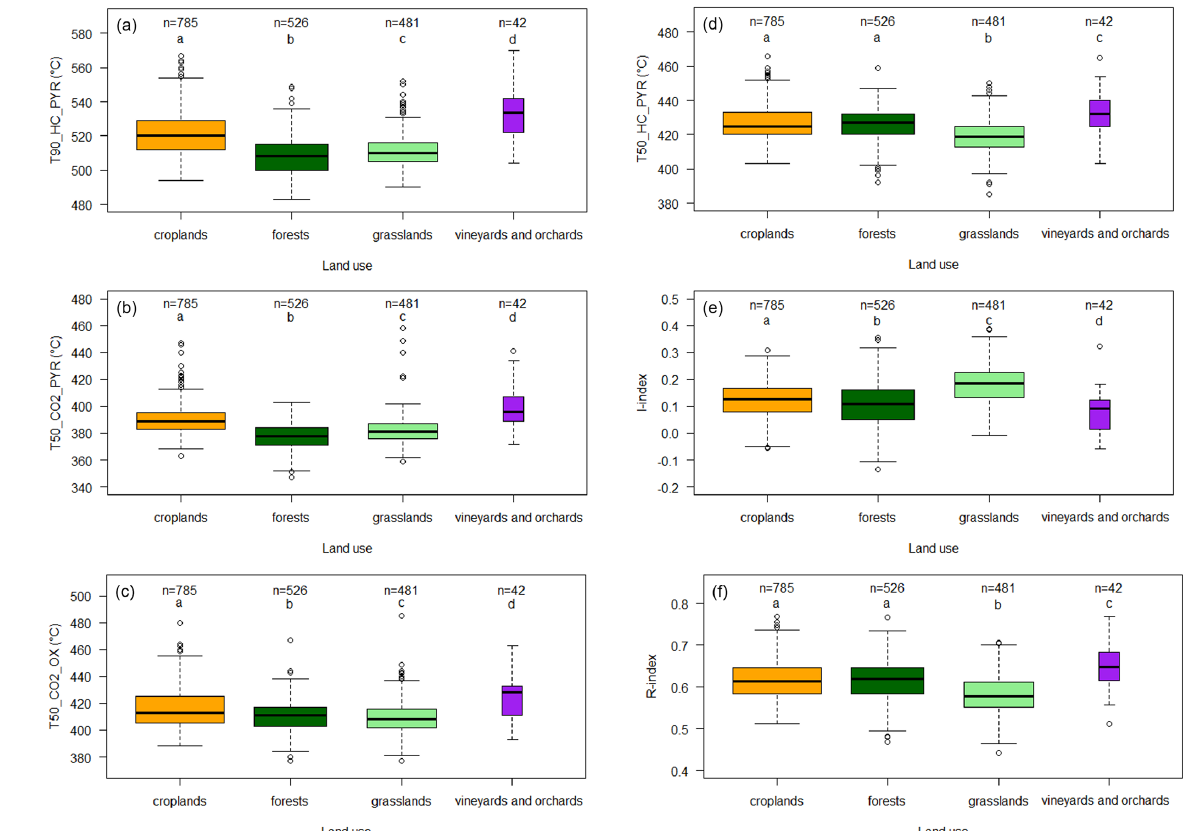
Figure 2. Effect of land cover on topsoil organic carbon thermal stability for the RMQS topsoil (0–30cm) samples under the four major land covers in France: croplands, forests, grasslands, and vineyards and orchards. The individual panels show the (a) T90_HC_PYR distribution, (b) T50_CO2_PYR distribution, (c) T50_CO2_OX distribution, (d) T50_HC_PYR distribution, (e) I -index distribution, and (f) R -index distribution. Samples are limited to those with Rock-Eval ® organic carbon yields ranging from 0.7 to 1.3. For the box plots, the solid black midline in each box is the median, the lower and upper edges are the respective first ( Q 1 ) and third ( Q 3 ) quartiles, and the lower and upper whiskers are the maximum between the minimum value or the first quartile minus 1.5 times the interquartile range (max [min; Q 1 − 1 . 5 × ( Q 3 – Q 1 )]) and the minimum between the maximum or the third quartile plus 1.5 times the interquartile range (min [max; Q 3 + 1 . 5 × ( Q 3 – Q 1 )]), respectively. Different letters indicate significant differences in the distribution of the values for the land uses according to a Kruskal–Wallis test ( p< 0 . 05) and a pairwise Wilcoxon rank sum test ( p< 0 . 05). The box width is proportional to the square root of n